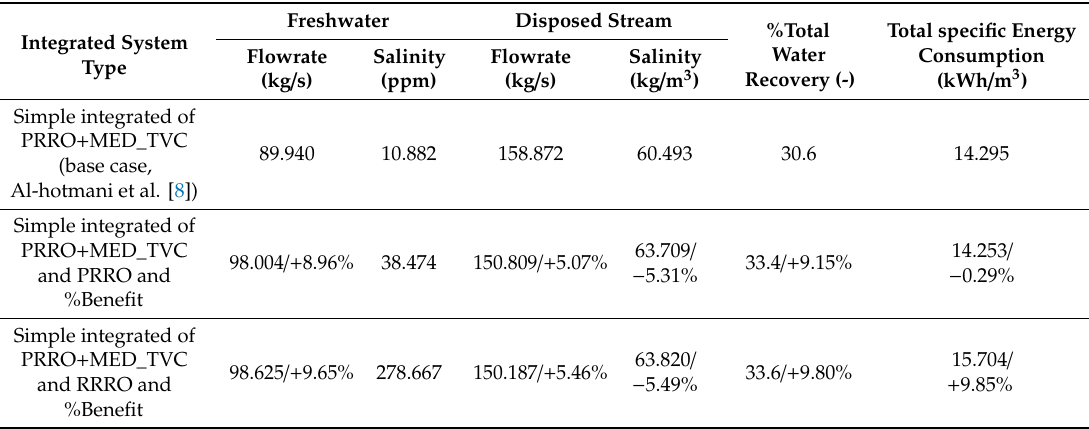
Table 3. Performance indicators of novel hybrid systems of MED_TVC and double RO processes compared to the base case design of